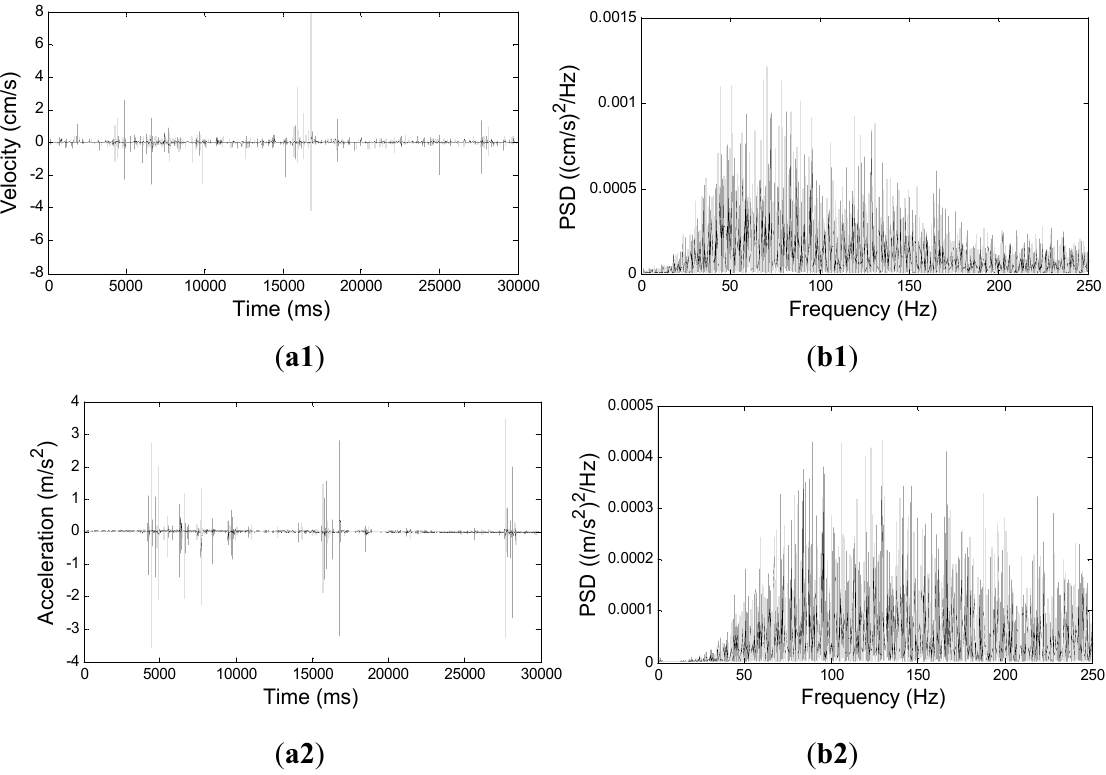
Figure 6. Ground vibrations detected by Z-axis of geophone and FBG sensor; ( a1 ) time-series data detected by geophone, ( b1 ) geophone signals in frequency domain, ( a2 ) time-series data detected by FBG sensor, and ( b2 ) FBG sensor signals in frequency